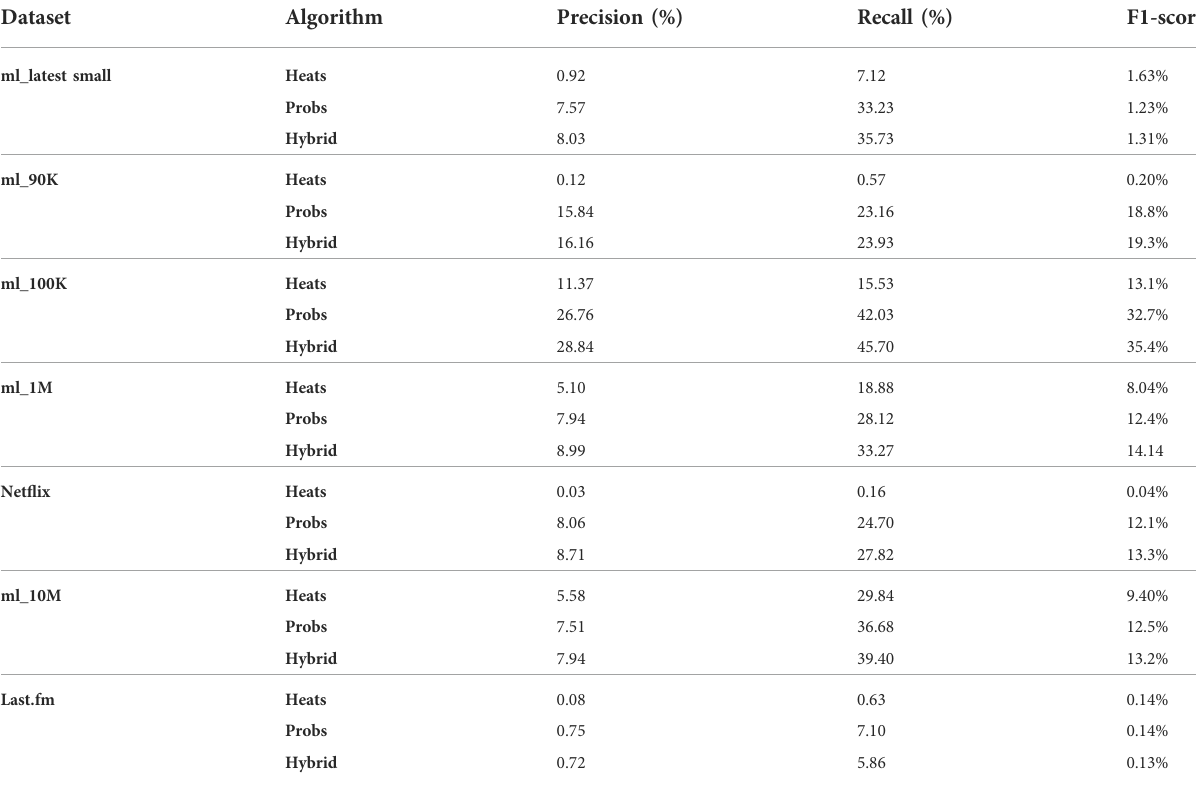
TABLE 2 Recommendation evaluations on seven datasets based on random selection of test sets.